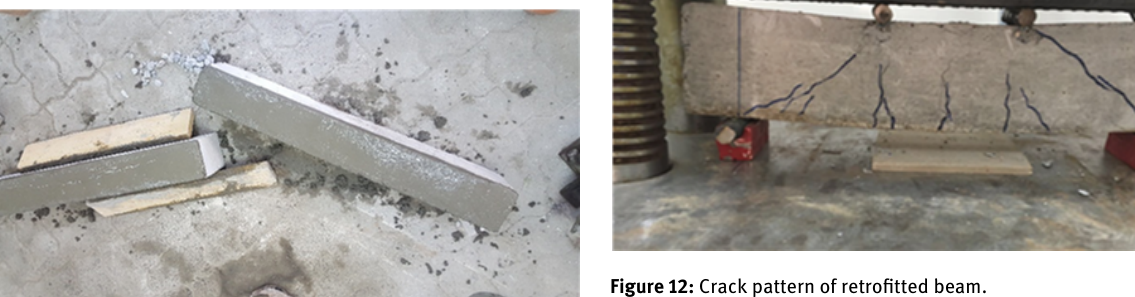
Figure 12: Crack pattern of retrofitted